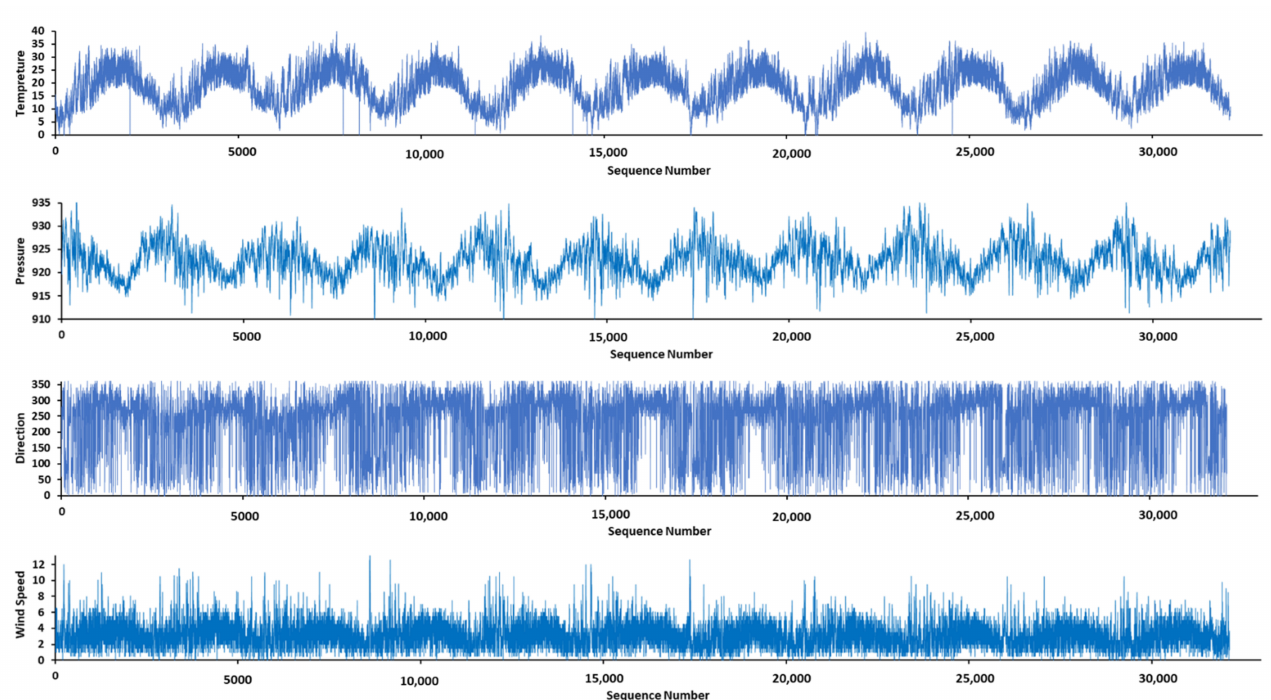
Figure 2. A full timeline of the distribution of all the possible values of each variable in the dataset.